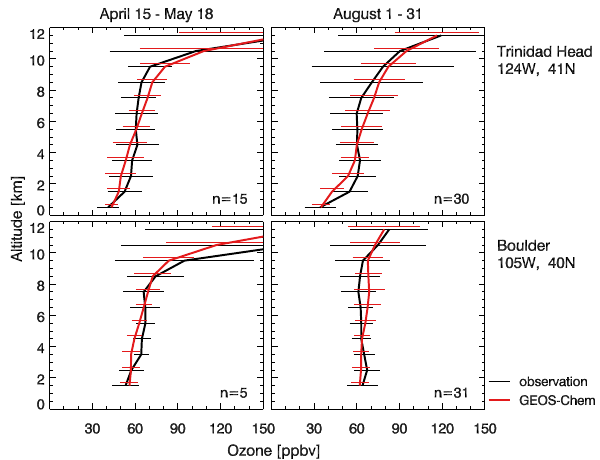
Figure 3. Mean ozone concentration profiles over Trinidad Head, California, (top panels) and Boulder, Colorado (bottom panels). The black lines show the means and standard deviations of ozonesonde data for the period of 15 April–18 May (left) and 1–31 August (right) 2006. The red lines show the corresponding model values. Numbers of profiles are shown